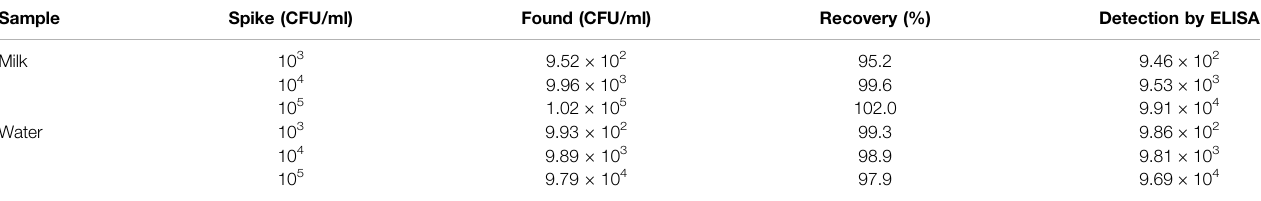
TABLE 2 | Electrochemical biosensor for monitoring E. coli O157:H7 in milk and water samples.